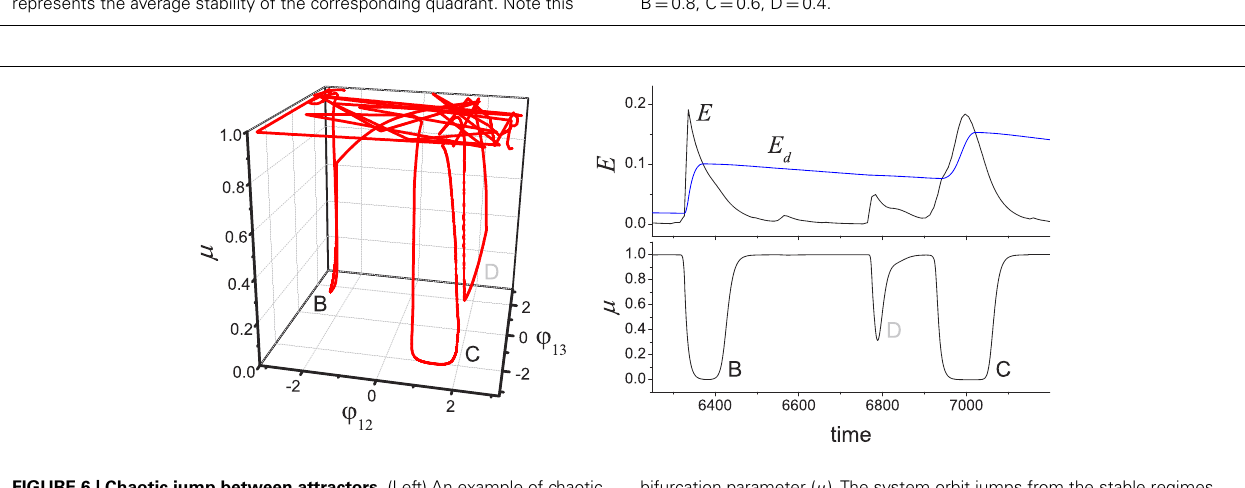
FIGURE 5 |Assignment of performance on the initial (basic) landscape (leftmost) .The performance map (rightmost) is generated by mixed Gaussian functions (of variance σ 2 = 0.4) whose mean positions are A:(-1.4, -1.3), B:(-1.9, 1.5), C:(1.5, -1.9), and D:(1.8, 1.8).The middle image shows the statistics of the visit durations in each of the four phase regions.The height of each bar is simply the total sum of the values at all points in each quadrant of the basic landscape, which represents the average stability of the corresponding quadrant. Note this